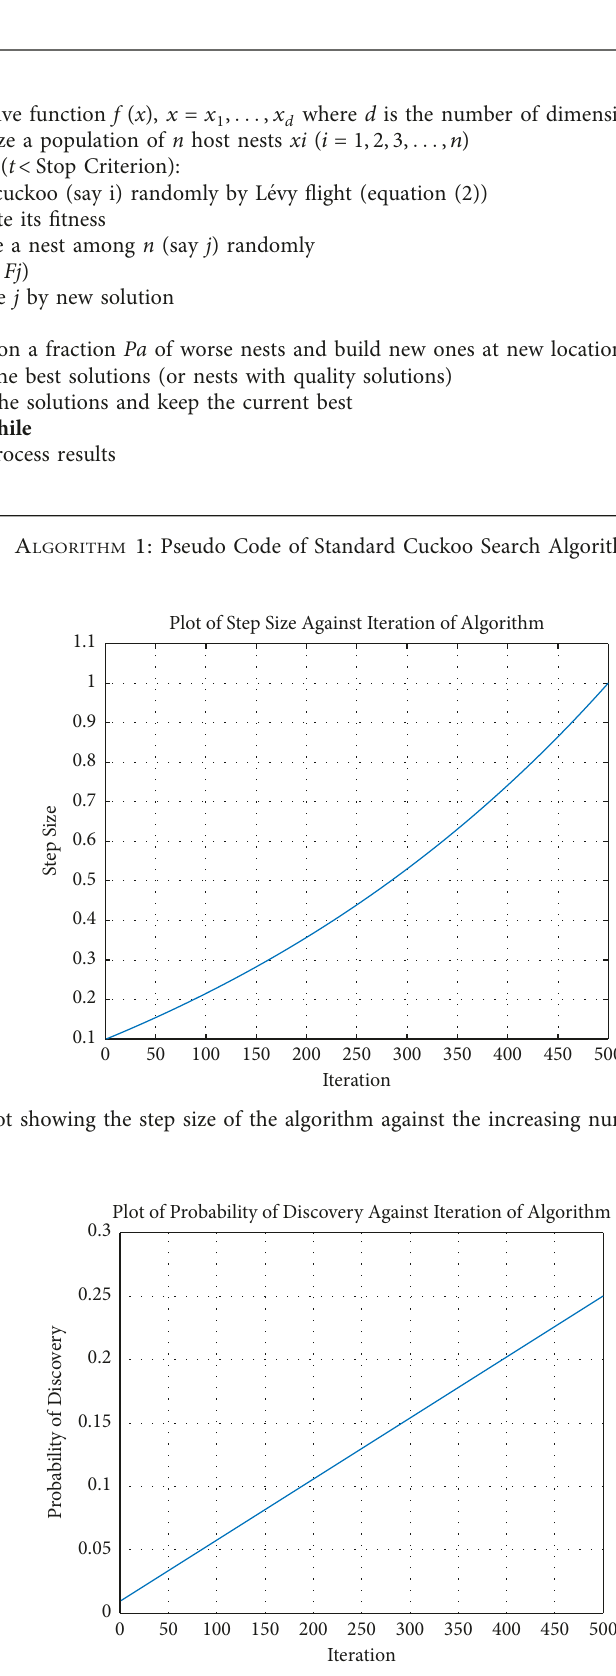
Figure 2: Plot showing the probability of discovery of the algorithm against the increasing number of